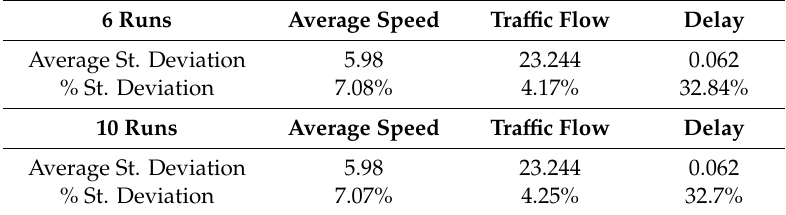
Table 1. Main key performance indicator (KPI) standard deviations—6 runs vs. 10 runs for 100% market penetration of equipped vehicles